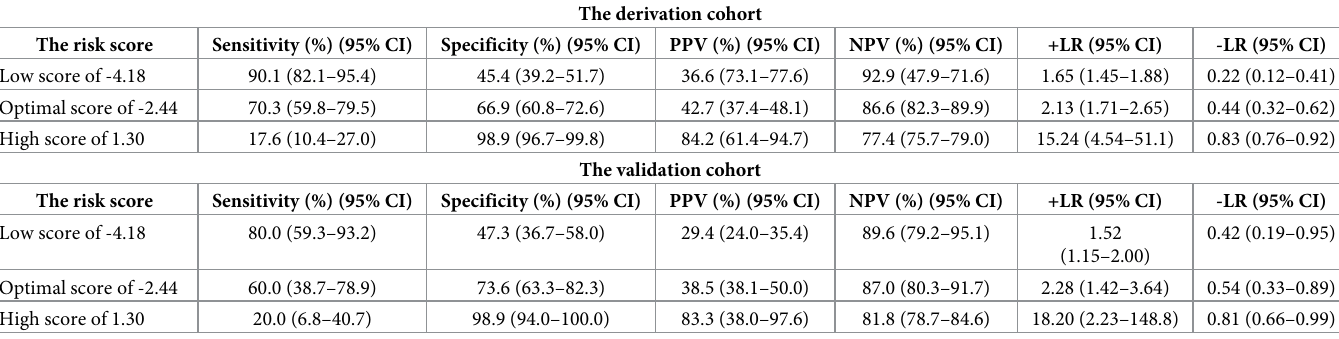
Table 4. The diagnostic performance of the risk score for predicting TB normalization within 6 weeks after endobiliary stent placement. The derivation